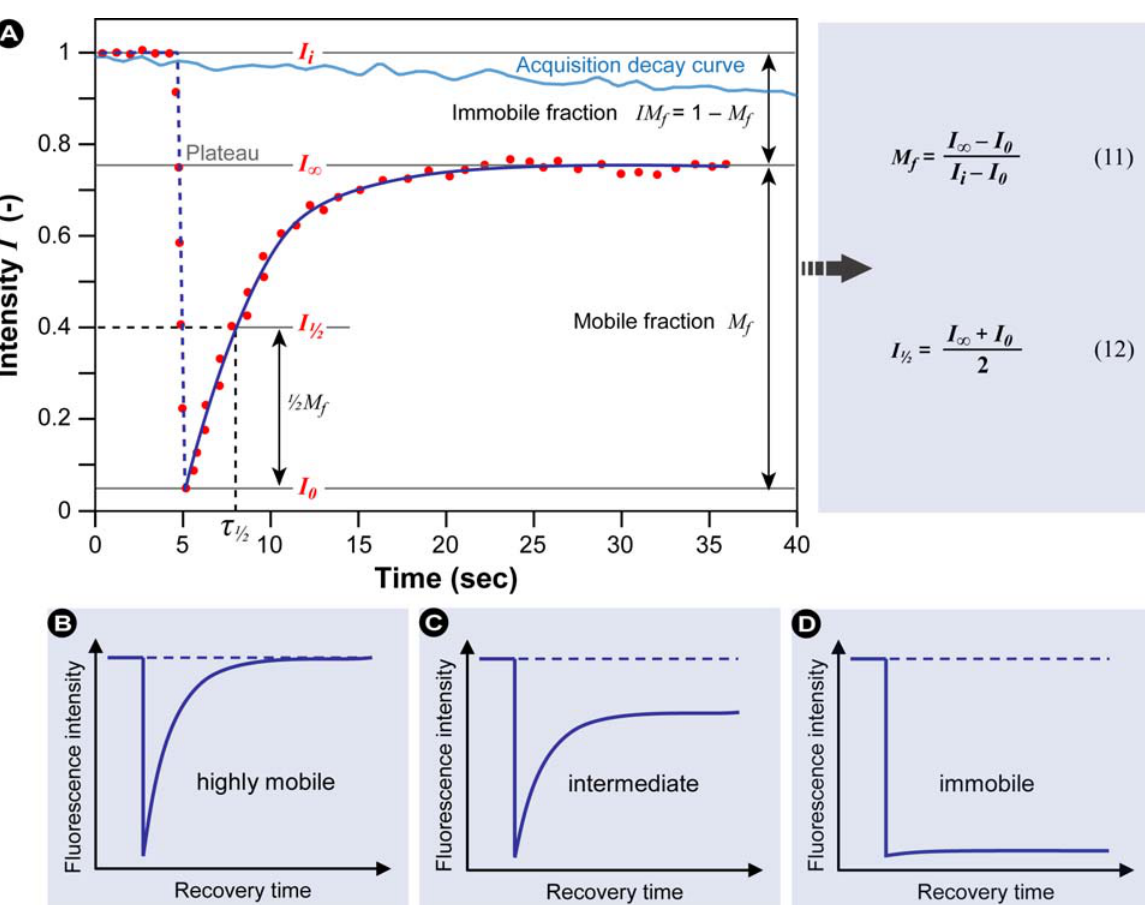
Figure 13. Anatomy of a typical FRAP curve. ( A ) From the initial (pre-bleach) ), the signal drops to a particular low value ( I ) as the high fluorescence intensity ( I i 0 intensity laser beam bleaches fluorochromes in the ROI. Over time the signal recovers ) to a maximal plateau value ( I ). From this plot and from the post-bleach intensity ( I 0 ∞ ), immobile fraction ( IM ), I and corresponding equations 11–12, the mobile fraction ( M f f ½ – the time for the exchange of half the mobile fraction between bleached and time ( τ ½ unbleached areas) can be calculated (Light blue line: reference photobleaching curve to correct for fluorescence loss during data acquisition). The information from the recovery to I ) can be used to determine the diffusion constant and the binding curve (from I 0 ∞ dynamics of fluorescently labeled proteins. Based on different recovery profiles, the protein mobility can be classified as ( B ) highly mobile with virtually no immobile fraction, ( C ) intermediate mobile with an immobile fraction, or ( D )